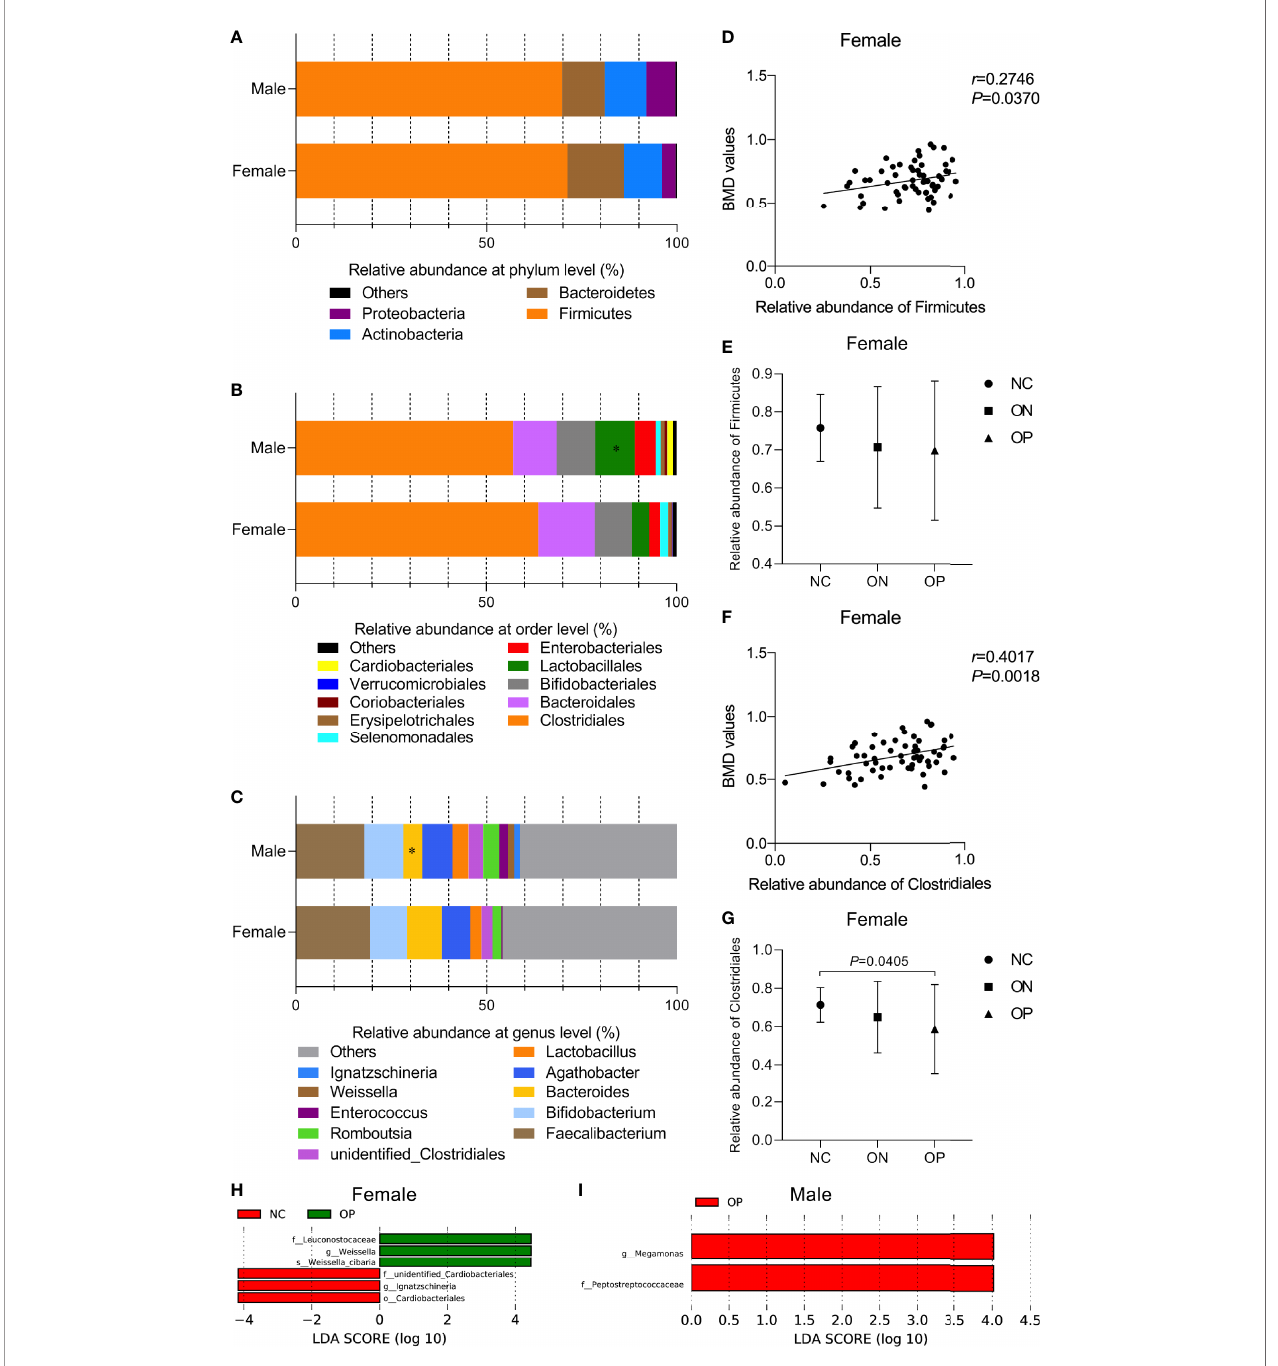
FIGURE 4 | Relative abundance of GM composition and its correlation with BMD values at different taxonomic levels in females and males. (A – C) Relative abundance of GM composition in female and male groups at the phylum level, order level, genus level, respectively. Compared with the female group, * P < 0.05. (D, E) The correlation of phyla Firmicutes with BMD values and the relative abundance of Firmicutes in the three subgroups of females. (F, G) The correlation of order Clostridiales with BMD values and the relative abundance of Clostridiales in the three subgroups of females. (H, I) LEfSe analysis of enriched GM community in the three subgroups of females and males. P < 0.05, LDA value >